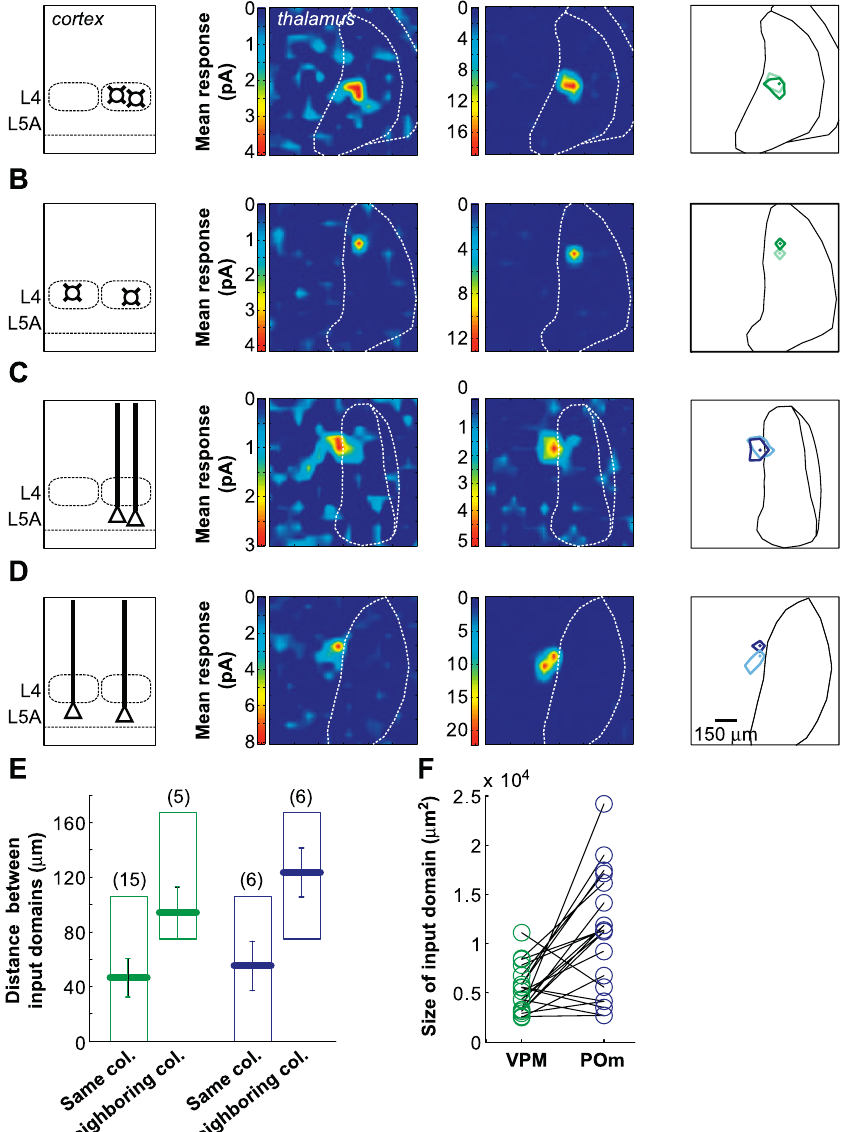
Figure 4. Thalamic Input Domains Projecting to Individual Cortical Columns (A–D) Schematic of the locations of recorded neurons (left), input maps (middle), and overlaid input domains (right) Circles in the input domains indicate the largest responses from a pair of L4 cells in the same column (A), a pair of L4 cells in neighboring columns (B), a pair of L5A cells in the same column (C) and a pair of L5A cells in neighboring columns (D). (E) Distance between the largest input in the synaptic input maps (green, VPM; blue, POm) from pairs recorded in the same column or in neighboring columns. The average (thick line), and the minimum and maximum distances between largest input across cells (rectangle) are shown. Numbers in parenthesis are the number of pairs. The pairs of cells located in the same column were three L4/L4, five L4/L5B, four L4/L6A, two L5B/L6A, one L6A/L6A, and six L5A/L5A. Pairs of cells located in neighboring columns were four L4/L4, one L4/L5B, and six L5A/L5A cells. (F) Areas of the input domains in VPM (green) and POm (blue) for pairs of L4/L5B/L6A, and L5A cells located in the same